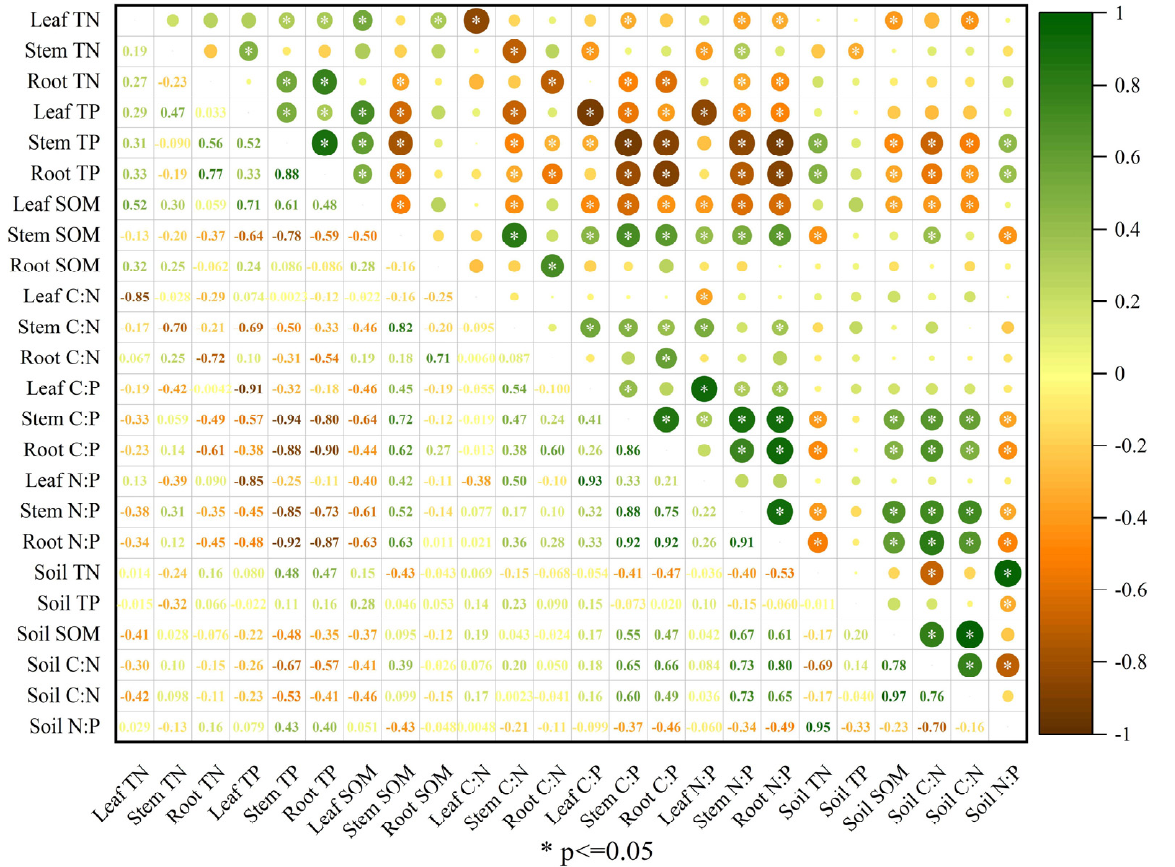
Figure 6. Spearman analysis of nutrition and stoichiometry of C. migao seedlings and soil in the REC stage. Leaf TN: the total concentration of nitrogen in leaves; Stem TN: the total concentration of nitrogen in stems; Root TN: the total concentration of nitrogen in roots; Leaf TP: the total concentra- tion of phosphorus in leaves; Stem TP, the total concentration of phosphorus in stems; Root TP: the total concentration of phosphorus in roots; Leaf SOM: the total concentration of carbon in leaves;